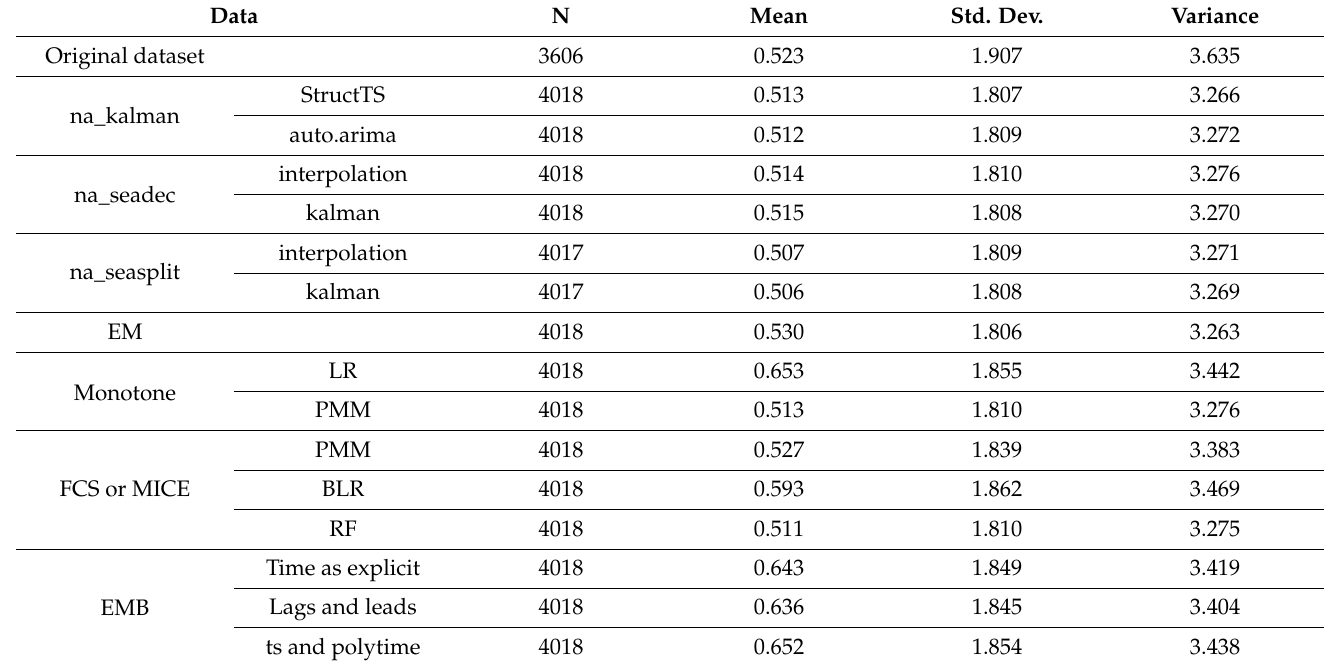
Table 8. Statistical metrics for comparison of imputation algorithms for the Zhidan